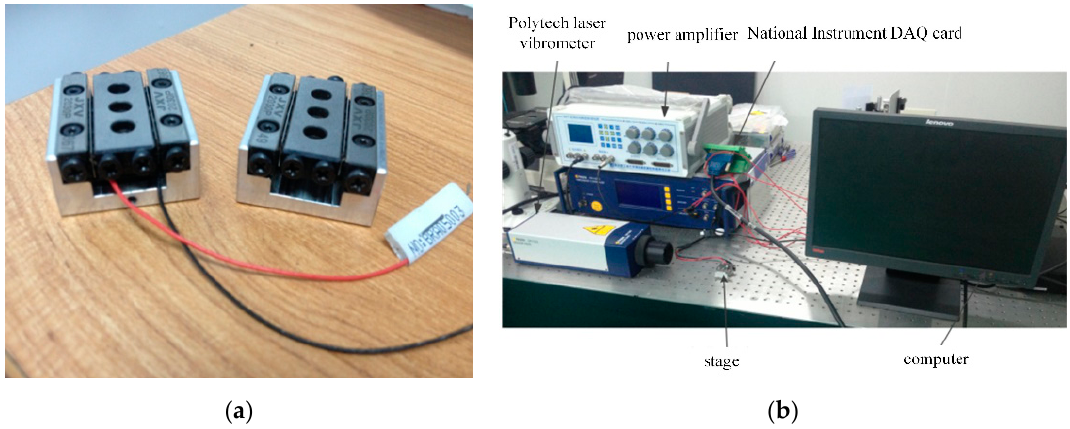
Figure 10. ( a ) Constructed stage; ( b ) experimental system for performance measurement. Reproduced with permission from [31]